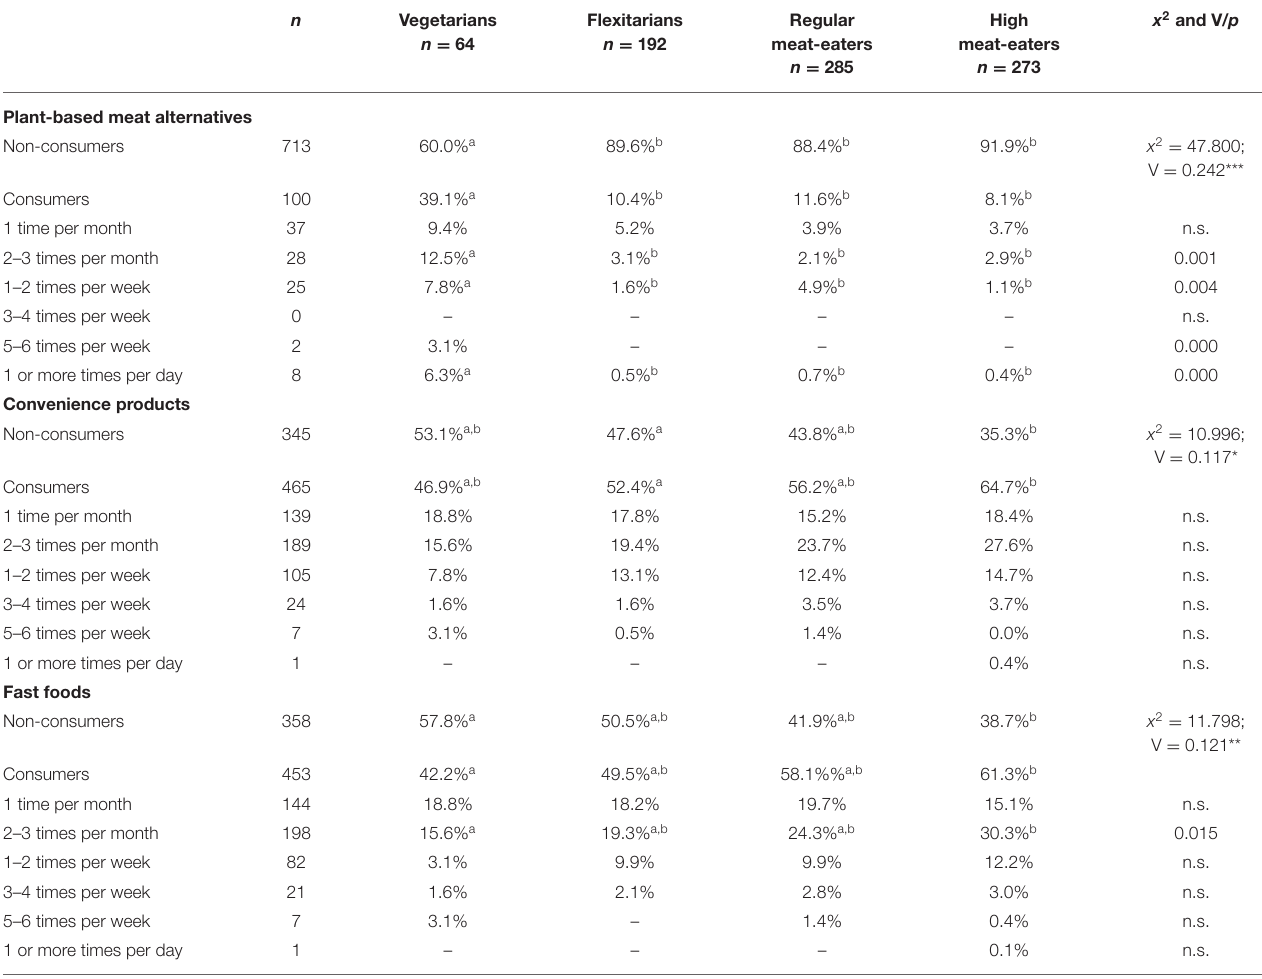
TABLE 4 | Consumption of plant-based meat alternatives, convenience products, and fast foods among dietary groups [vegetarians (no meat), flexitarians ( ≤ 1 × meat/week), regular eat-eaters ( ≤ 7 × meat/week), high meat-eaters ( > 1 × meat/day)]. n Vegetarians Flexitarians Regular n = 64 n = 192